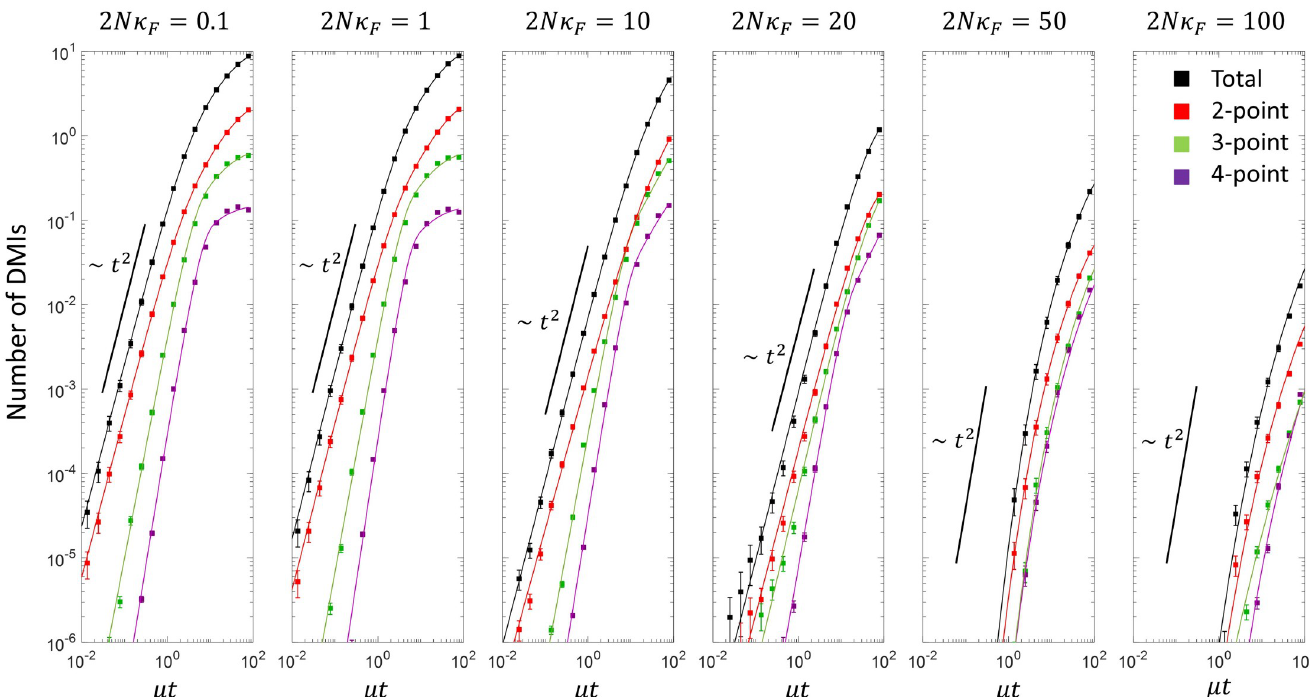
Fig 5. Plot of the total number of DMIs vs divergence time, together with their decomposition into the total number of 2-way, 3-way, 4-way DMIs, for various scaled populations sizes. For 2 N κ � 20 the solid lines correspond to fits of the simulation data to Eq 1, while for 2 N κ F